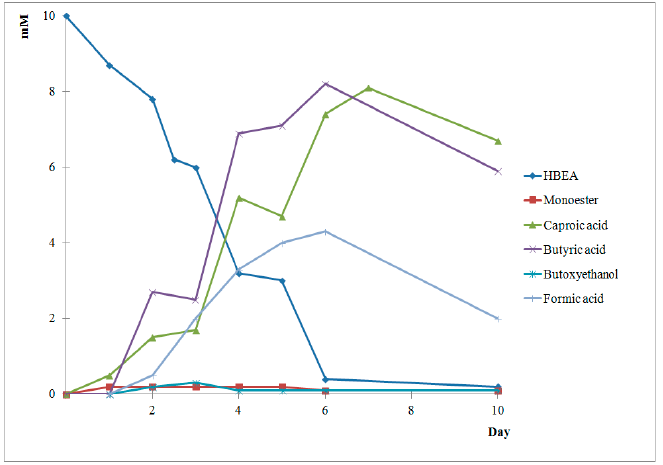
Figure 4. Biodegradation of HBEA in soil.